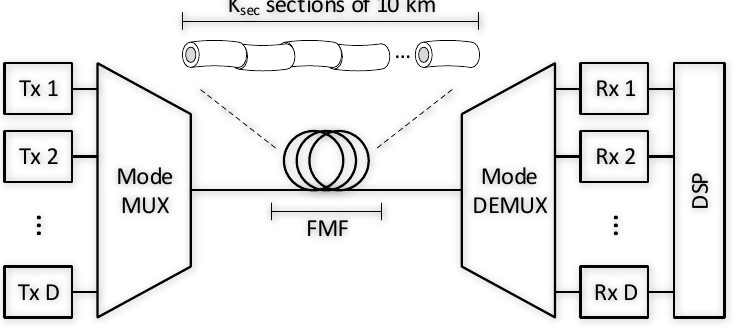
Figure 7. General set-up for numerical simulation model of multi-mode multiplexed